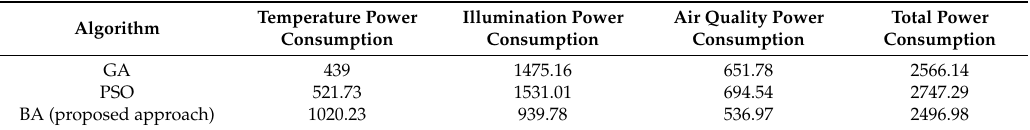
Table 1. Power consumption comparison of BA with GA and